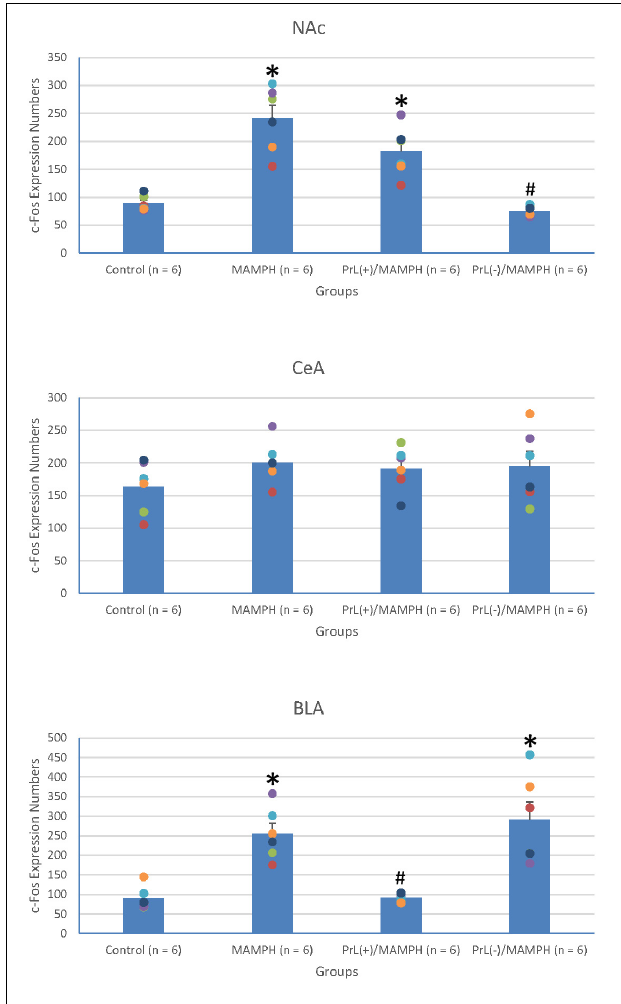
FIGURE 7 | MAMPH administrations were tested to label c-Fos expression in the NAc and the amygdala’s CeA, and BLA for the control ( n = 6), MAMPH ( n = 6), PrL(+)/MAMPH ( n = 6), and PrL(–)/MAMPH groups ( n = 6) by injecting NMDA or saline into the PrL. PrL(+): Injection of a low concentration of NMDA to excite the PrL neurons; PrL(–): Injection of a high concentration of NMDA to destroy the PrL neurons. Differences in c-Fos expression levels in the NAc, CeA, and BLA among all groups were analyzed by one-way ANOVA, followed by Tukey’s post hoc test if a significant difference was appeared among groups. ∗ p < 0.05 indicates significant differences compared with the control group; # p < 0.05 indicates significant differences compared with the MAMPH